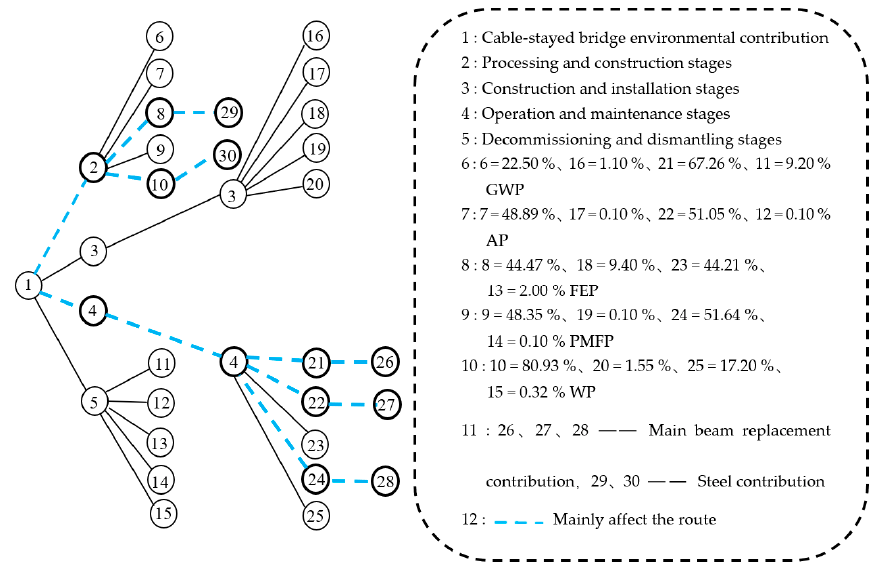
Figure 11. Schematic diagram of the Markov chain probabilities of the cable-stayed bridge.